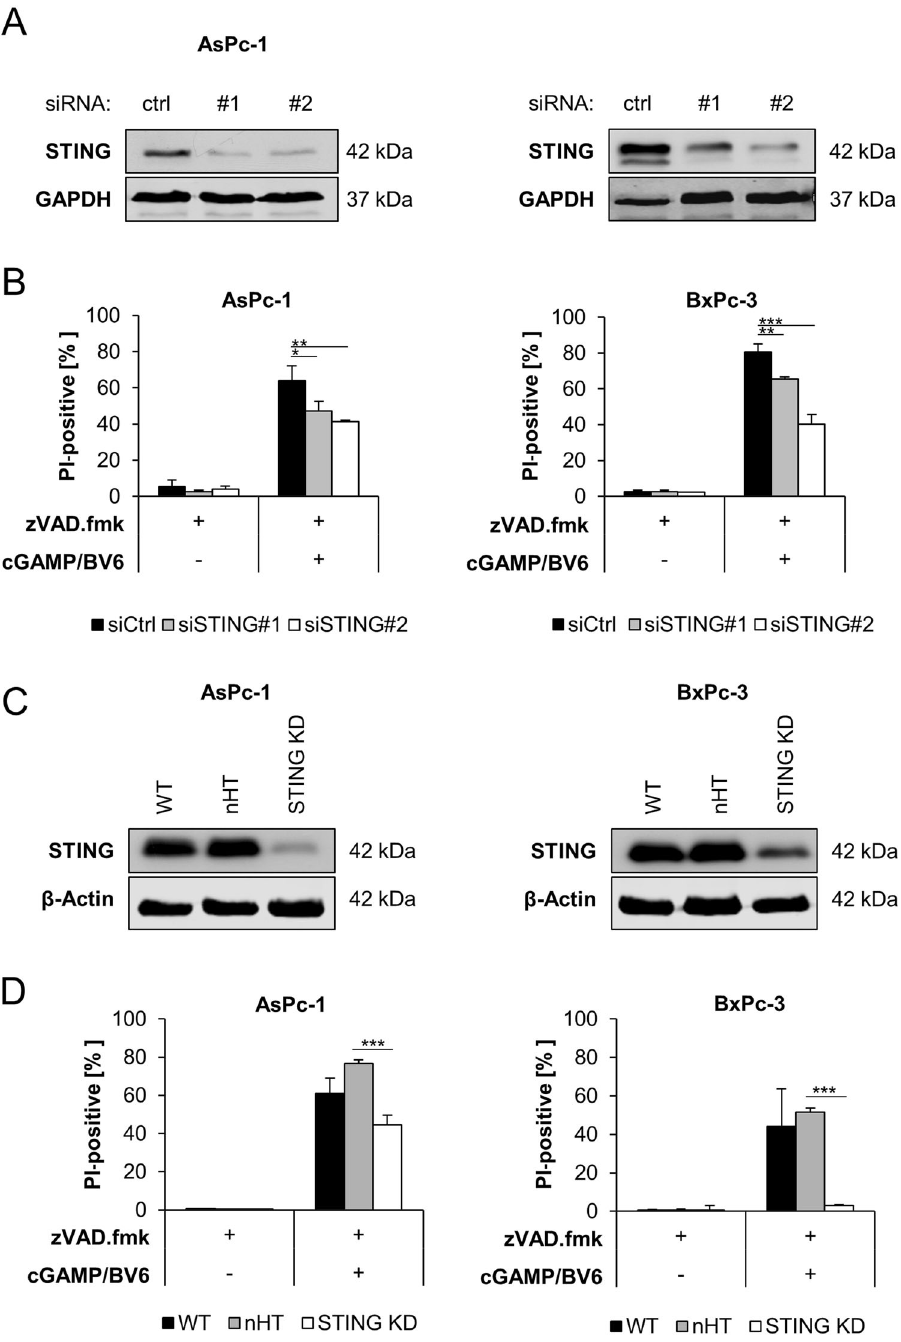
Fig. 5 STING is required for 2 ′ 3 ′ -cGAMP/BV6/zVAD.fmk-induced cell death. A Western blot analysis of STING expression in the indicated PC cell lines after 48 h of transfection with non-silencing RNA (ctrl) or siRNA targeting STING. GAPDH serves as loading control. Representative blots of at least two different independent experiments are shown. B AsPc-1 and BxPc-3 cells were transfected with control siRNA (siCtrl) or two independent siRNAs targeting STING and were treated with 20 μ M zVAD.fmk for 48 h in the presence or absence of 4 µg/ml 2 ′ 3 ′ -cGAMP and 5 µM BV6. The amount of cell death was calculated by quantifying PI uptake determined with the ImageXpress Micro XLS system. Data are presented as percentage of PI-positive cells, and mean and SD of three independent experiments performed in triplicate are shown. ** P < 0.01, *** P < 0.001. C Western blot analysis of AsPc-1 and BxPc-3 subjected to nHT and STING CRISPR/Cas9 knockdown. β -Actin serves as loading control. Representative blots of at least two different independent experiments are shown. D AsPc-1 and BxPc-3 cells were subjected to nHT and STING CRISPR/Cas9 knockdown, and treated with 20 μ M zVAD.fmk for 48 h in the presence or absence of 4 µg/ml 2 ′ 3 ′ -cGAMP and 5 µM BV6. The amount of cell death was calculated by quantifying PI uptake determined with the ImageXpress Micro XLS system. Data are presented as percentage of PI-positive cells, and mean and SD of three independent experiments performed in triplicate are shown. *** P <